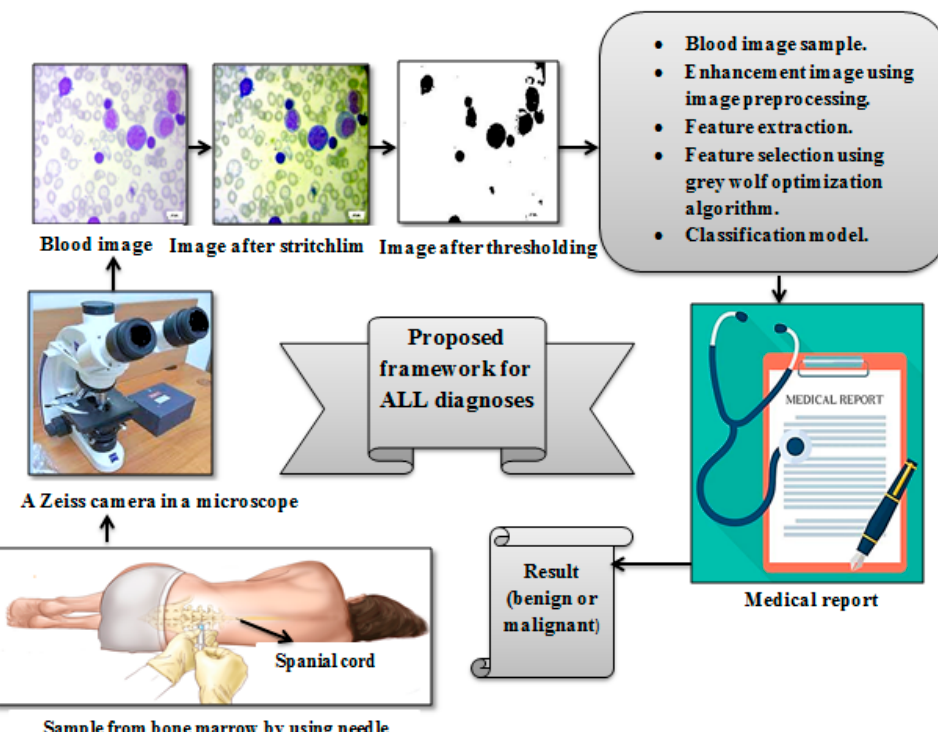
Figure 11. Proposed framework for leukemia diagnosis.